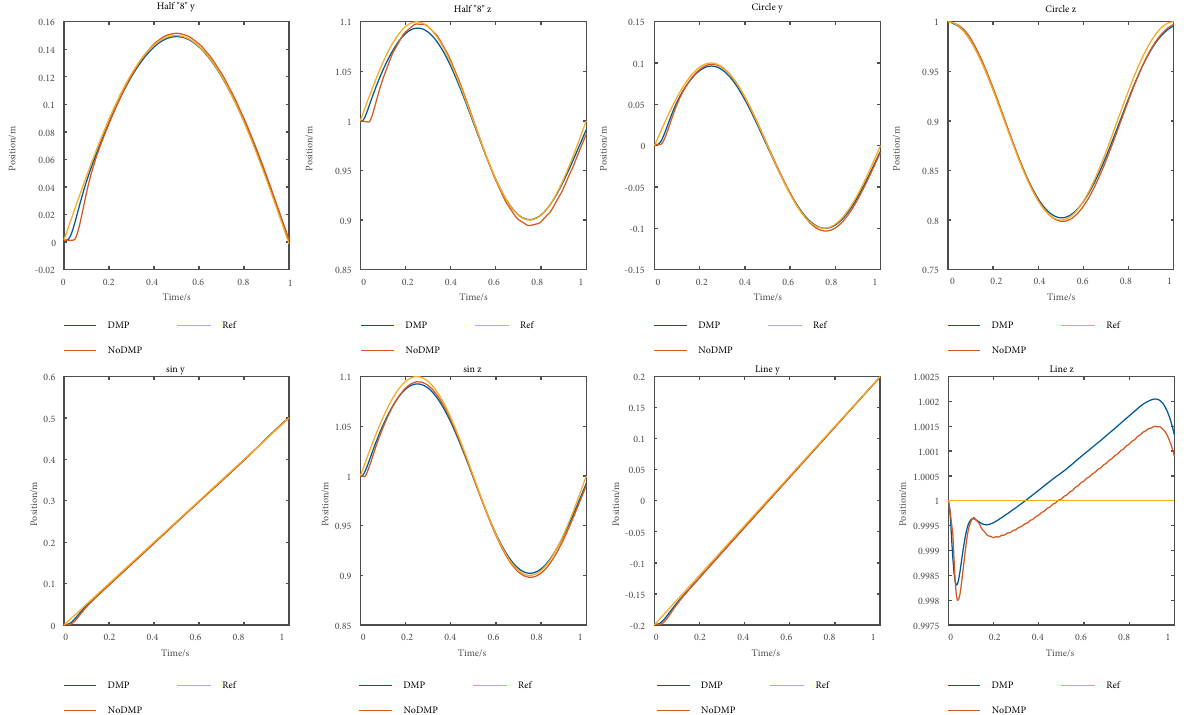
Figure 8: Position curve of the four simulations in Cartesian space.